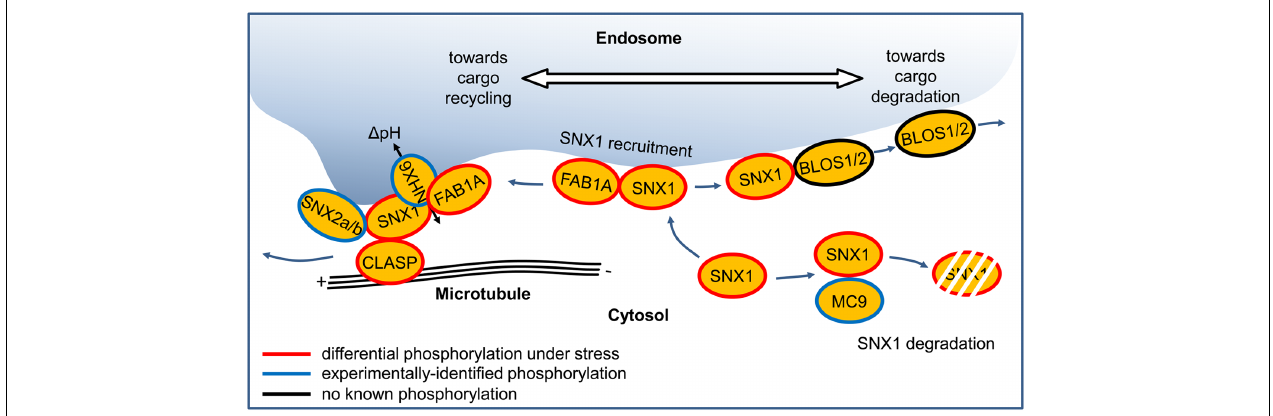
FIGURE 5 | A model of the events involved in SNX1-mediated protein recycling. The surface of the endosome in an idealized cell containing all SNX1 interactors is represented. The “plus” and the “minus” ends of a microtubule are indicated. Proteins are represented as oval shapes bordered by black lines (when no phosphorylation has been experimentally demonstrated), blue lines (when phosphorylation was observed), and red lines (when differential phosphorylation was shown under stress).